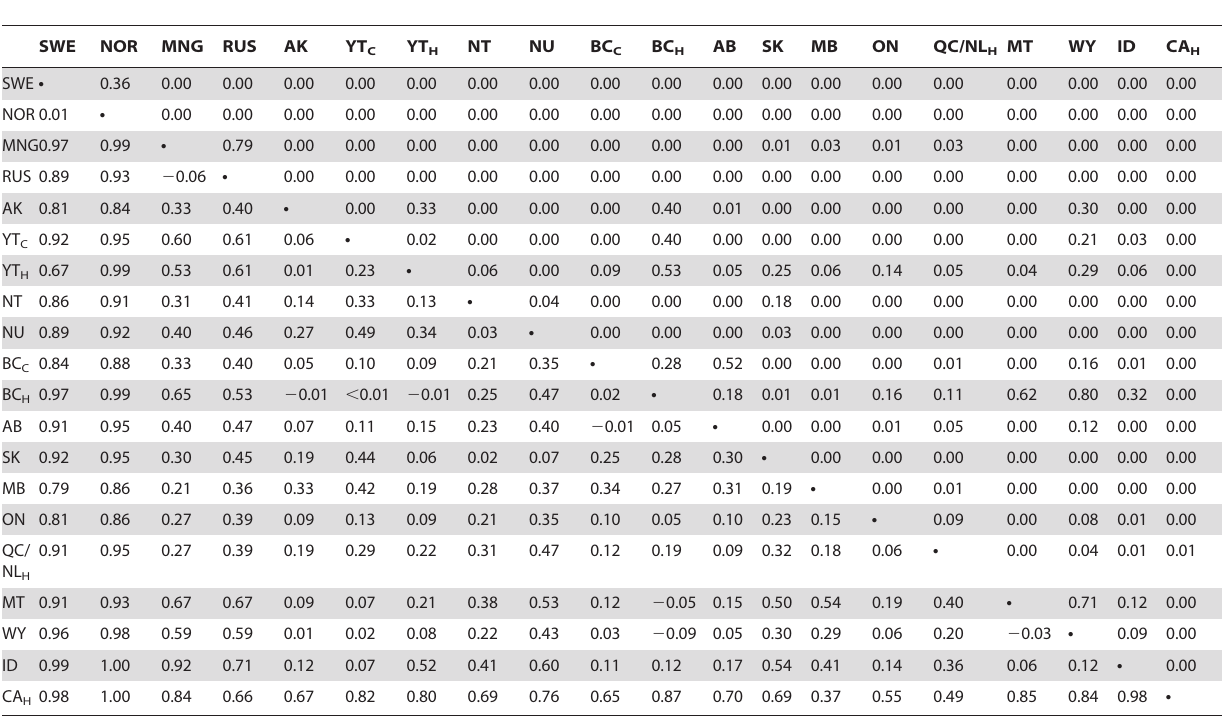
Table 2. Pairwise estimates of population genetic distance for mtDNA among sampling localities ( W ST , below diagonal), and associated P values (above diagonal).